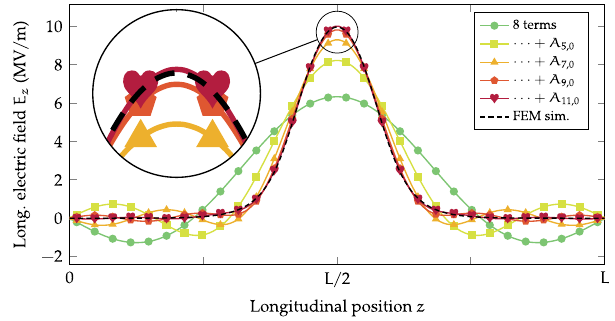
FIG. 10. Approximation of the electric field simulated in COMSOL (black dashed line) on the beam axis of a trapezoidal cell by the potential function with increasing number of